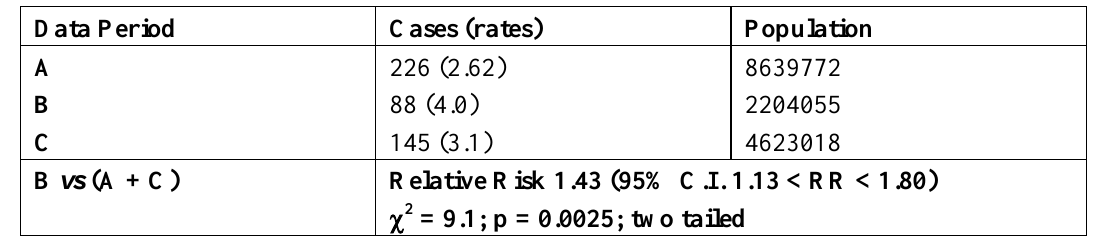
Table 5. Infant leukemia in the combined population of UK, Germany [3] and Greece [2] using all UK data from